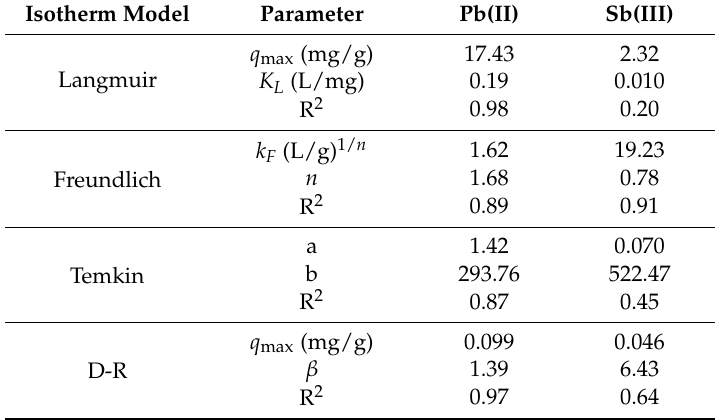
Table 2. Parameters of different isotherm models for biosorption of Pb(II) and Sb(III) by B. subtilis biomass.